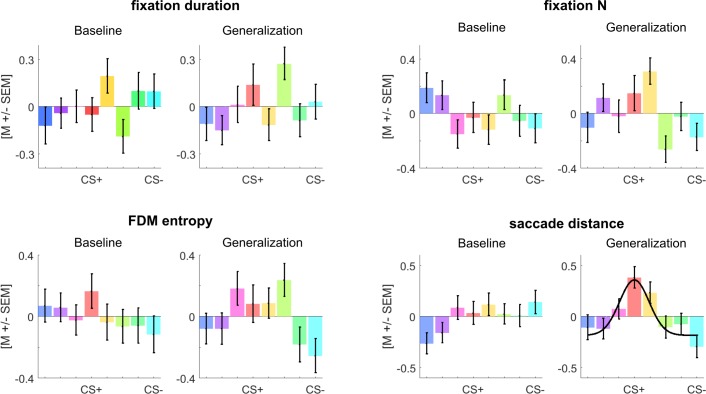
Generalization profiles of common fixation features.Common fixation features, such as fixation duration, number of fixations (fixation N), saccade distance and average entropy in FDMs for baseline and generalization phase. Features were extracted from single trial FDMs, z-scored within subject and experimental phase, then averaged across participants. Error bars depict the SEM across subjects. The black horizontal curve indicates where features a significantly tuned to the CS+ (p<0.001, log-likelihood ratio test, Gaussian model vs. flat null-model).